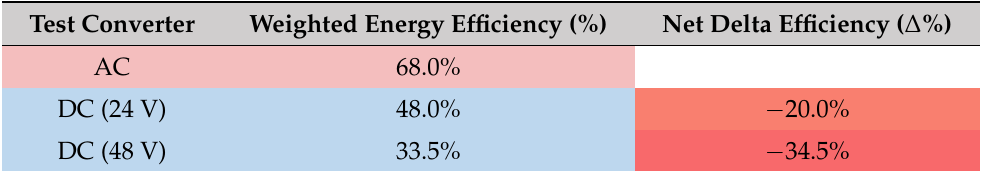
Table 8. Delta Efficiency (DC-AC) for simulation with converters rated at 110 W.